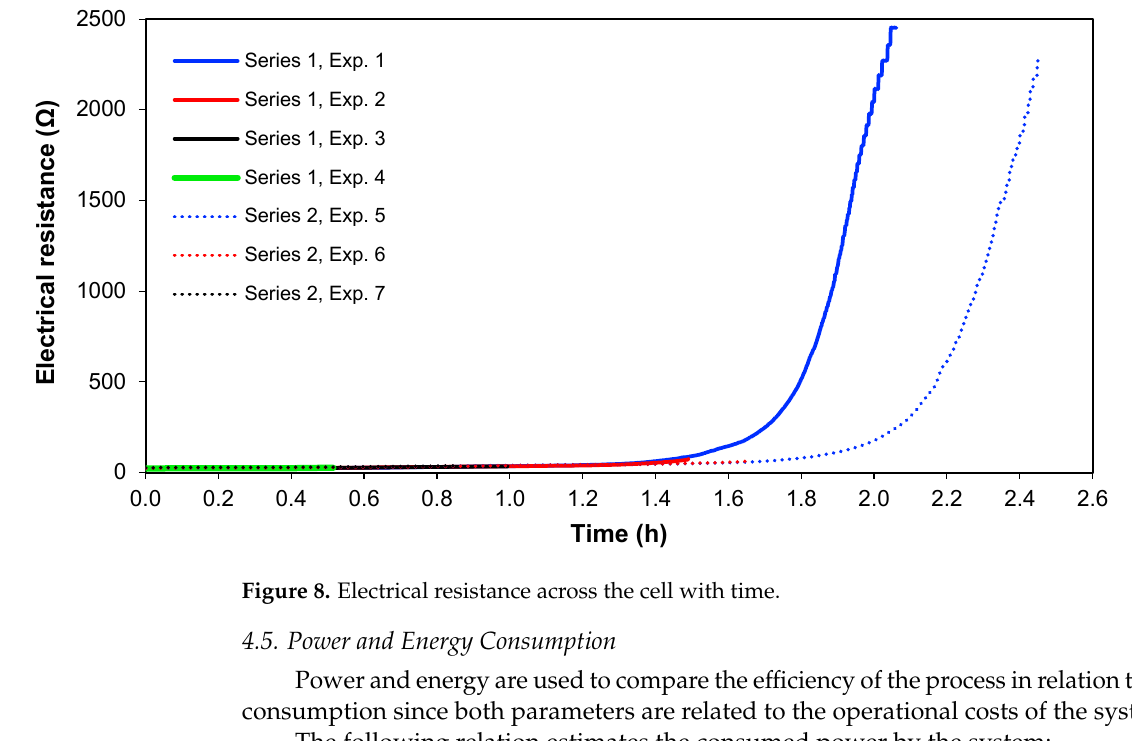
Figure 8. Electrical resistance across the cell with time.